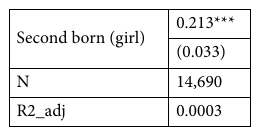
Table 6. Effects of second born girls on education on educational